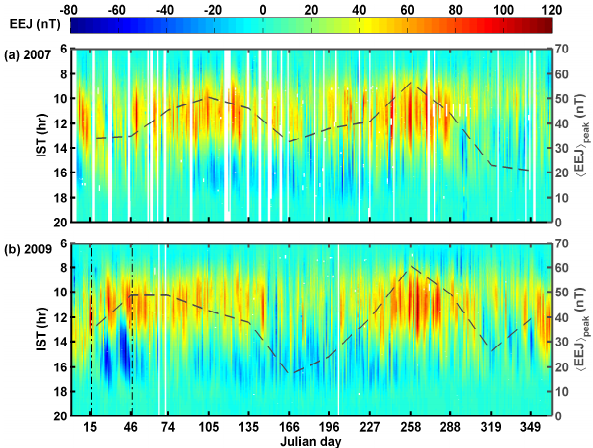
Figure 3. Number of days with partial blanketing E s (4MHz ≤ fbE s ≤ 8MHz) and total blanketing E s (fbE s ≥ 8MHz) for each season during (a) 2007 and (b) 2009. The percentage of number of days with E sb is given over each bar corresponding to each season.